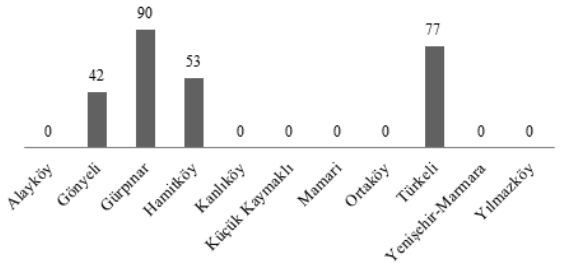
Figure 1. Total Woodland Areas in Nicosia Central Region (TRNC State Planning Organization, 2017)